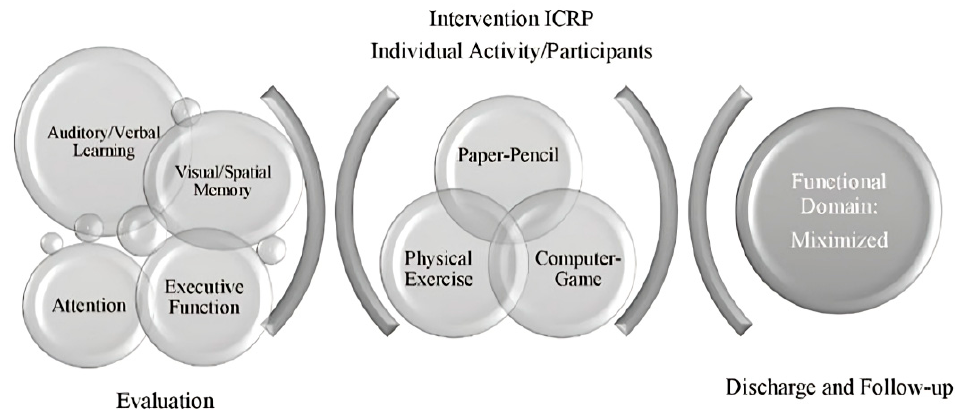
Figure 2. The Integrative Cognitive Rehabilitation Program Theoretical Model.